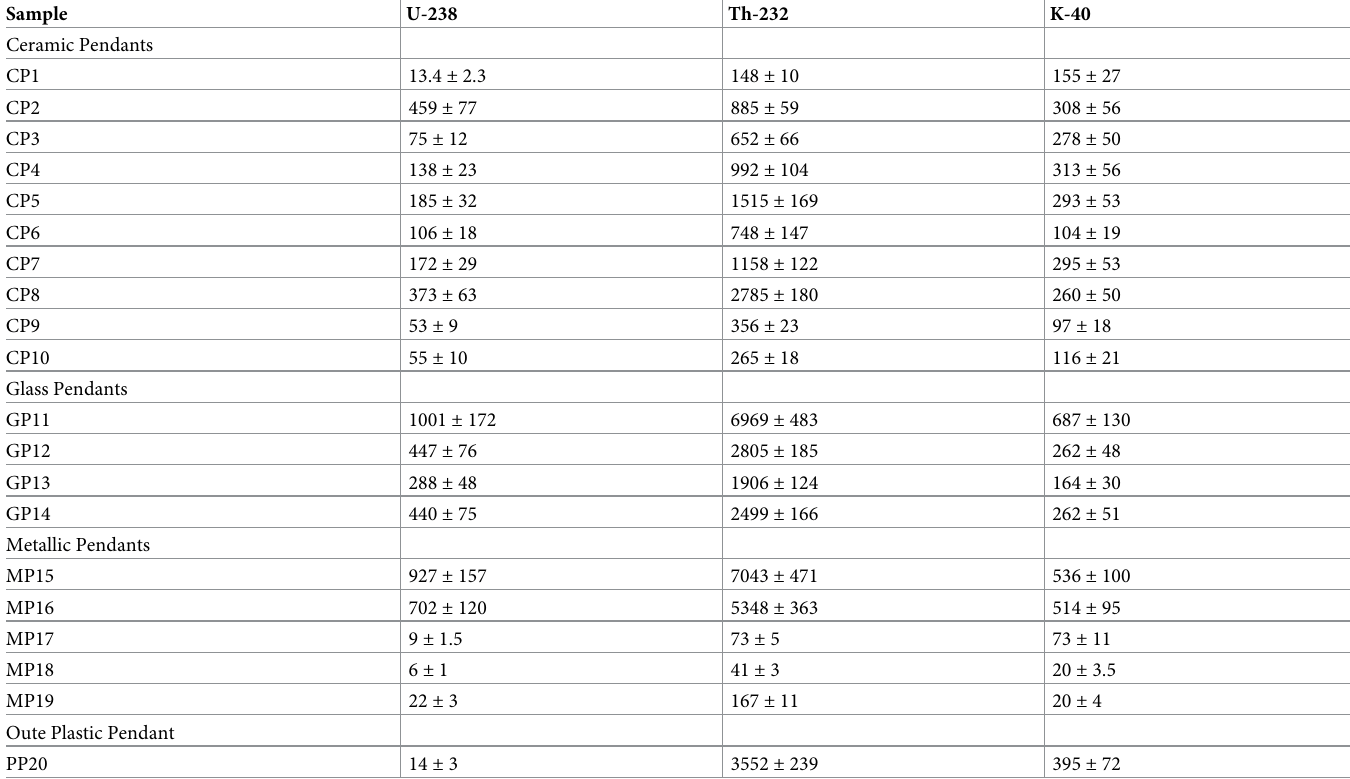
Table 1. Activity (in Bq/pendant) of U-238, Th-232 and K-40 in the pendants.